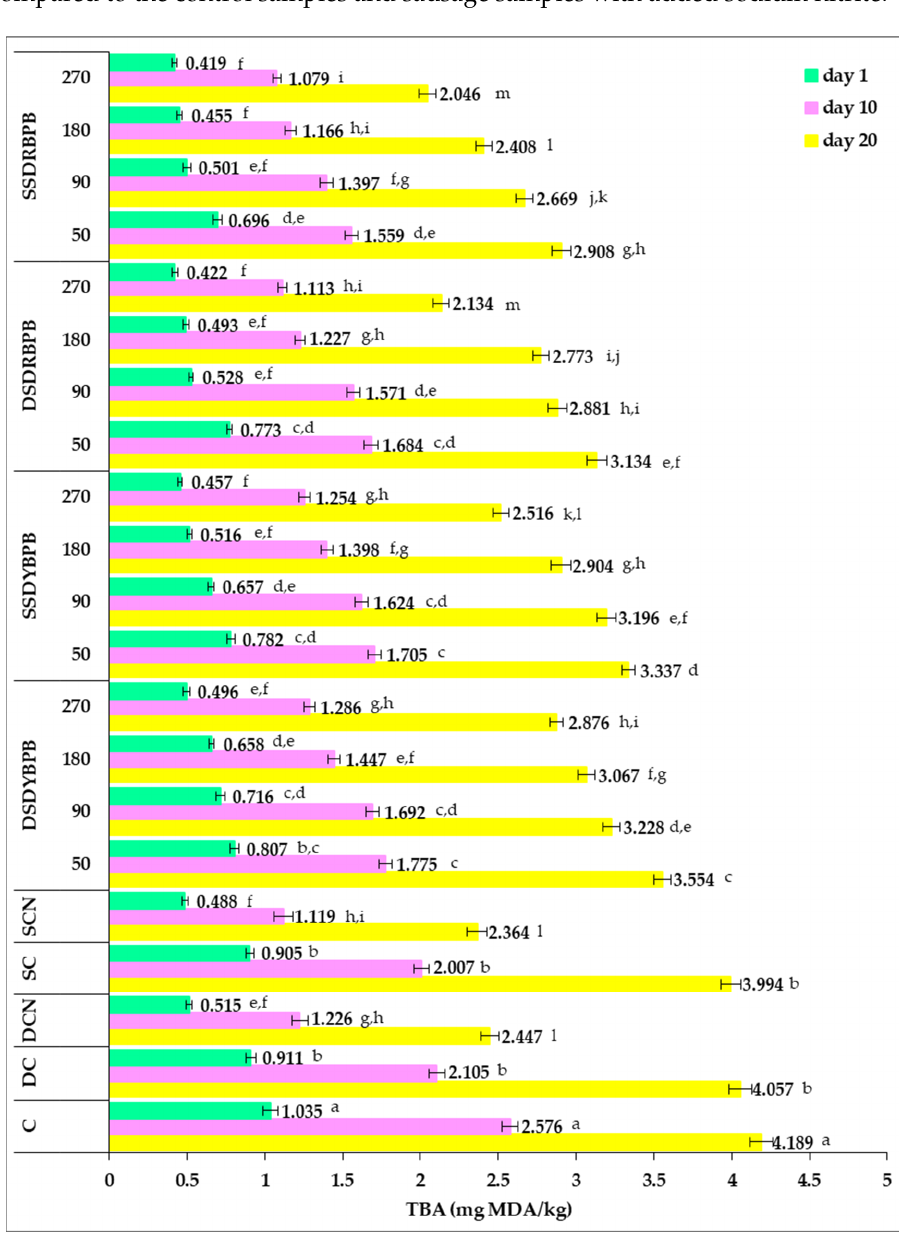
Figure 6. Effect of supplementing sausage formulas with bell pepper processing by-products on TBA value during 20 days of storage. Results represent the mean value of three independent analyses ± SD indicated by the error bars. a–m t -test was used to compare significant differences between the values obtained for sausage formulas (both control and sausage samples supplemented with different doses of dried bell pepper processing by-products); data from the same day of analysis showing different exponents show significant differences ( p < 0.05).